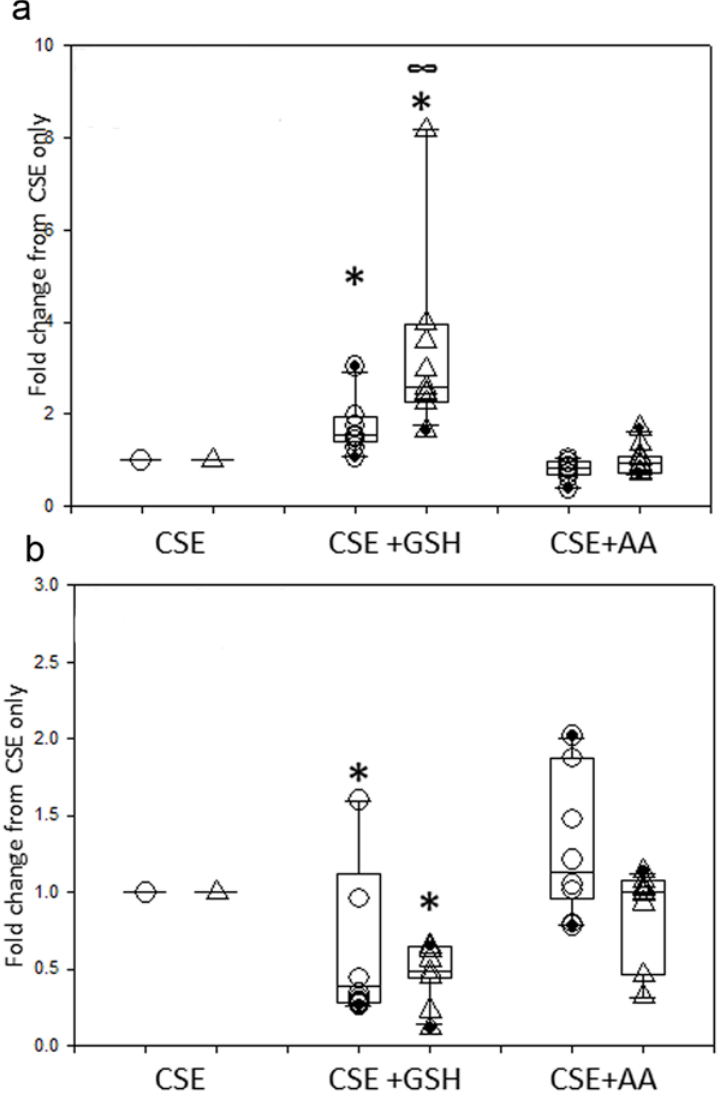
Fig 3. Ability of GSH, but not AA, to protect against CSE-induced cell death. PBEC obtained from non- asthmatic or asthmatic donors were treated for 24h with 20% CSE alone or in the presence of GSH (1mM) or AA (250nM). Changes in cell viability (a) and EA (b) were then evaluated with AxV staining. The results are displayed as a box plot showing median, interquartile range and 5 – 95% confidence intervals of fold changes from CSE alone using PBECs from 10 non-asthmatic ( (cid:1) ) and 10 asthmatic ( Δ ) donors. * = p < 0.05 according to Wilcoxon Signed Rank tests comparing GSH+CSE with CSE only. 1 = p < 0.05 according to a Mann Whitney U test comparing CSE+GSH treatment between PBECs from non-asthmatic and asthmatic donors.